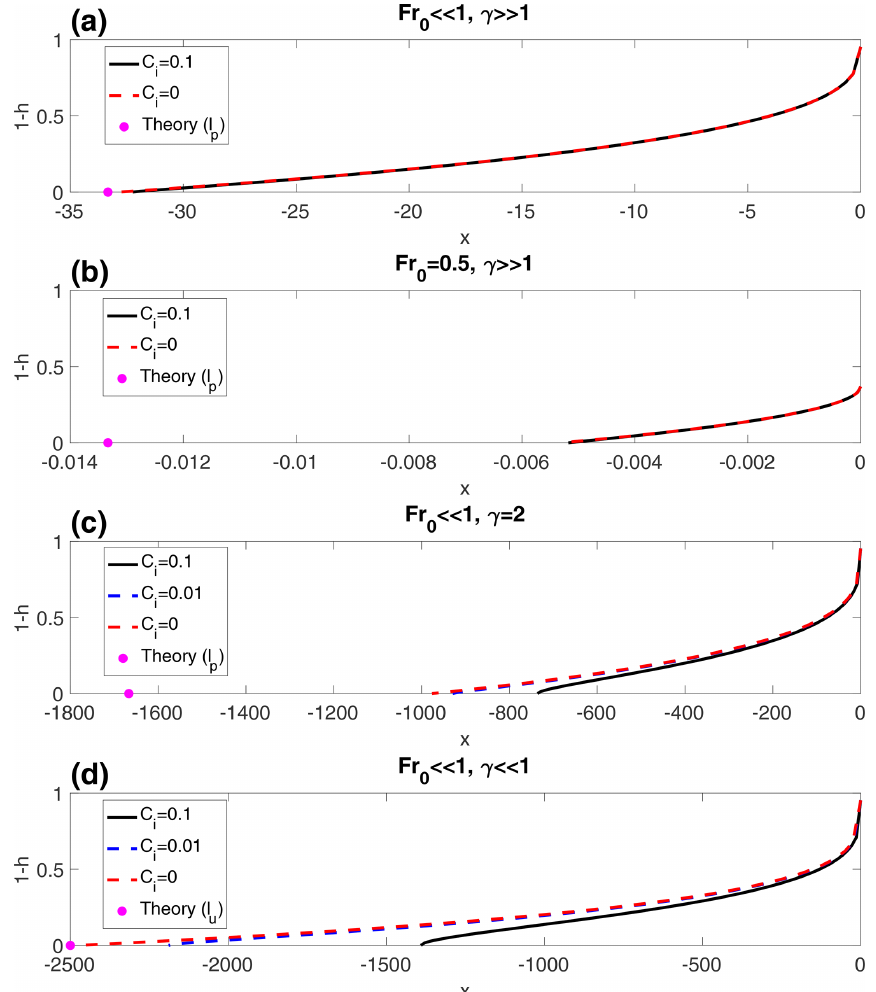
Figure 2. Comparison to analytic approximations of seawater intrusion distance, as well as numerical solutions of shallows water equations under various assumptions. 1 − h is the non-dimensional thickness of the seawater layer, which goes to zero at the seawater intrusion distance. (a) Low Froude number ( Fr 0 (cid:28) 1) and densely obstructed macroporous water sheet flow ( γ (cid:29) 1). (b) Moderate though sub-critical Froude number ( Fr 0 = 0 . 5) and densely obstructed macroporous water sheet flow ( γ (cid:29) 1). (c) Low Froude number ( Fr 0 (cid:28) 1) and moderately (though close to maximum packing density of spheres) obstructed macroporous water sheet flow ( γ = 2). (d) Low Froude number ( Fr 0 (cid:28) 1) and unobstructed water sheet flow ( γ (cid:28) 1). Other parameters used include C i = 1 (scaled) and (cid:50) =